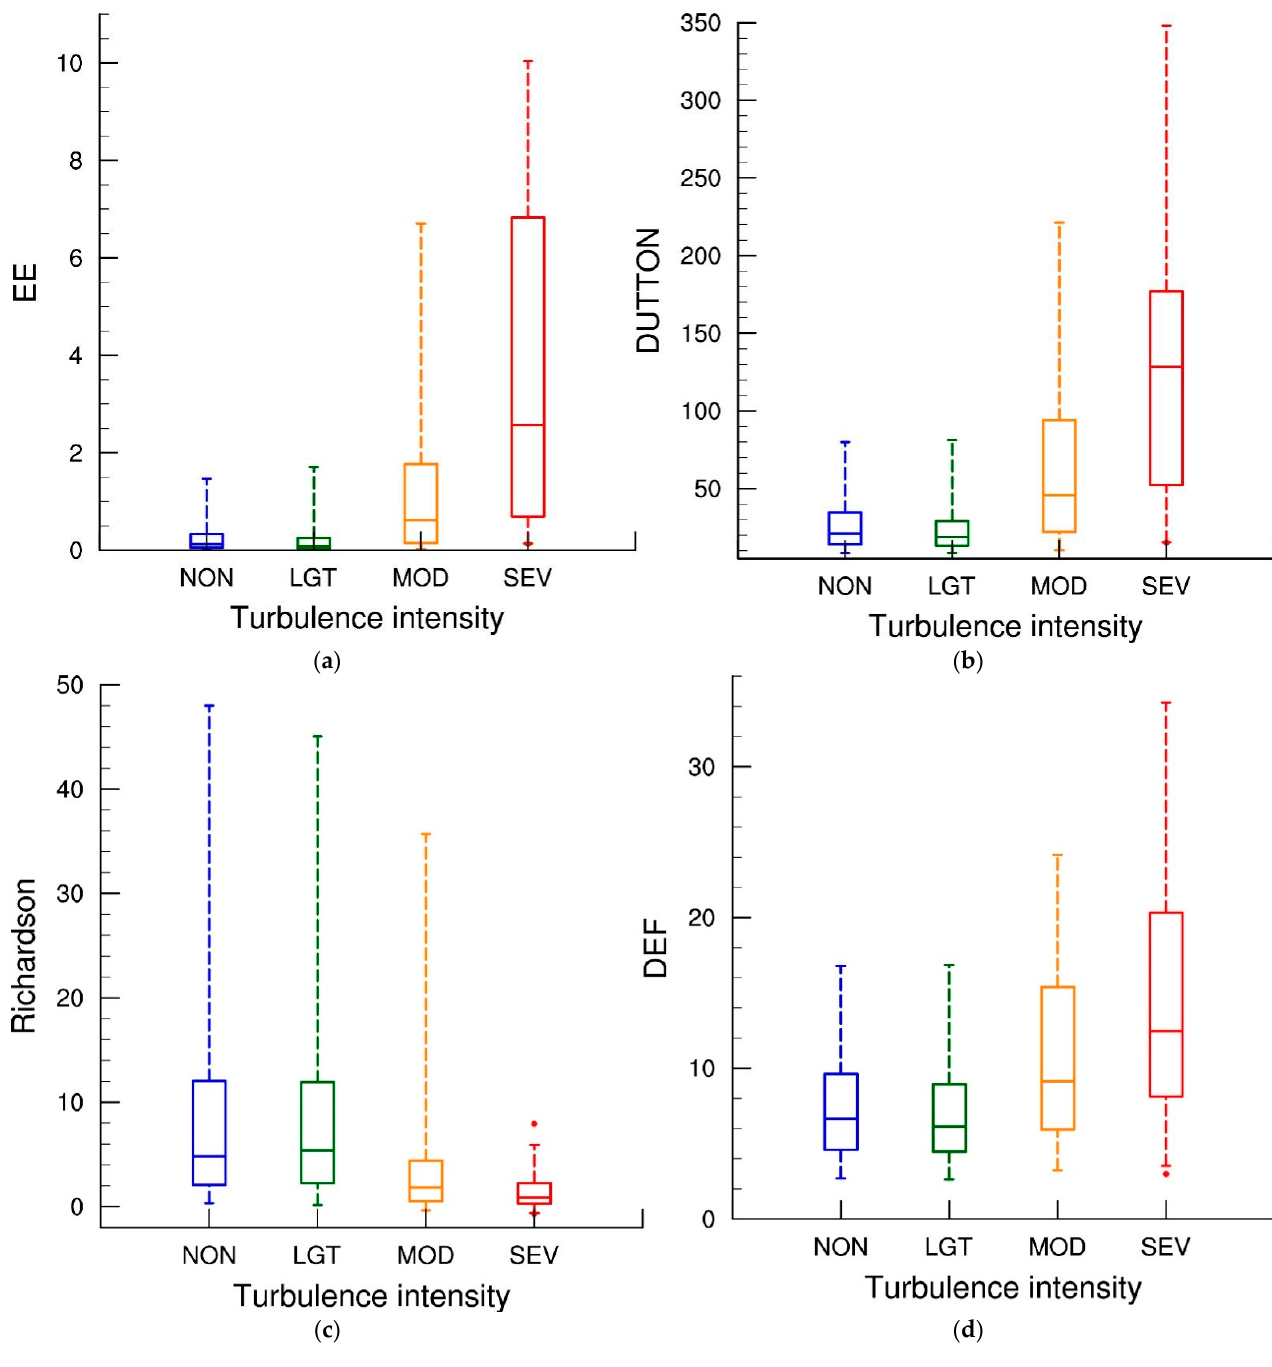
Figure 5. Box-plots of the distribution of: ( a ) EE (10 − 9 m 2 s − 3 ), ( b ) DUTTON (m s − 1 km − 1 ), ( c ) Richardson number, and ( d ) DEF (10 − 6 s − 1 ). These box-plots were constructed for four classes of turbulence (NON, LGT, MOD, and SEV). Statistical parameters in the box-plot are the 95th and 5th percentiles (upper and lower tick marks, respectively), 75th and 25th percentiles (upper and lower boundaries, respectively) and median (line inside the boxes).